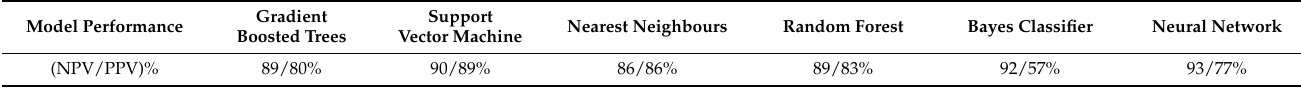
Results of six machine learning algorithms to predict DAP ≤ 2.8 Gy · cm 2